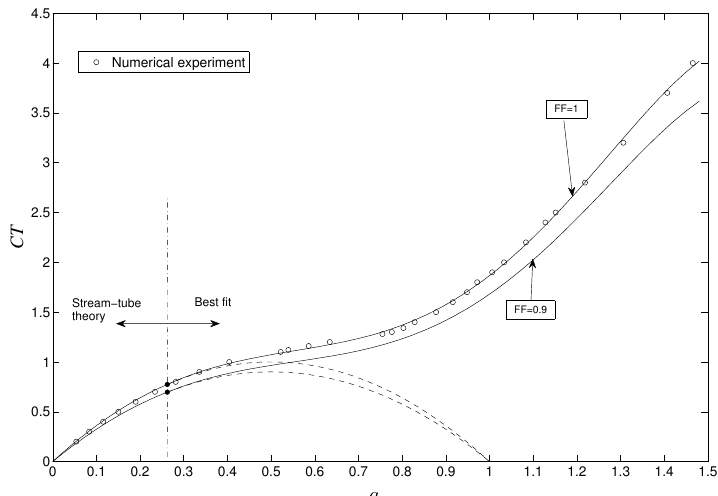
Figure 11. Thrust coefficient CT versus axial induction factor a obtained by the Actuator disk model, including tip-hub losses FF = 1 and FF = 0.9. The dashed parabolas represent the discarded portions of the theoretical CT parabolic